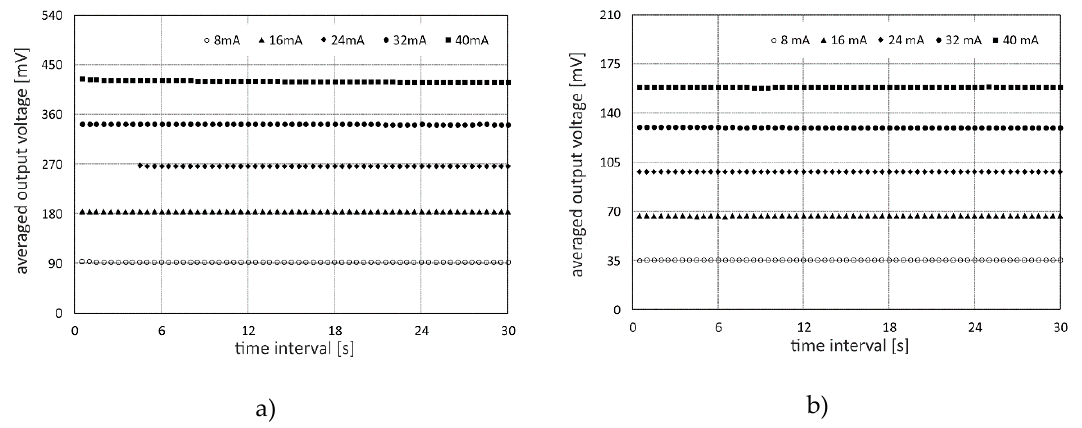
Figure 14. Long-term signal stability analysis of a multi-plane detector assembled with a lutetium yttrium oxyorthosilicate (LYSO) ( a ) bar and ( b ) sandwich block and exposed at various electron beam currents and at constant detector height of z 1 = 49 mm.